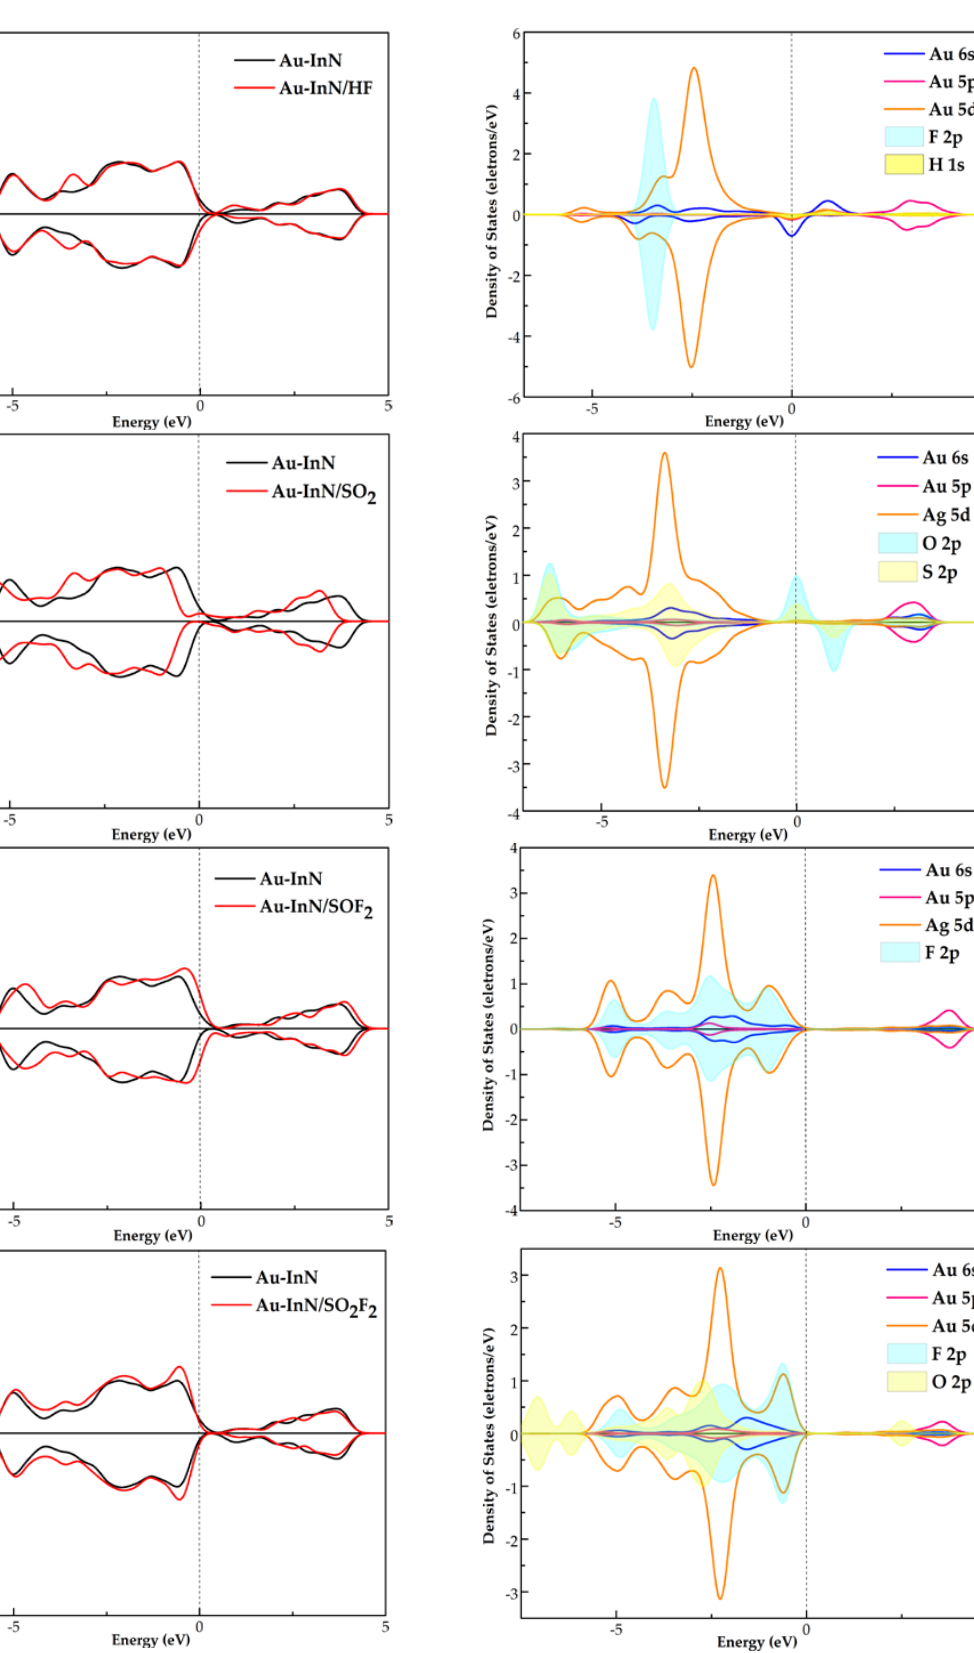
Figure 5. TDOS and PDOS of ( a ) HF, ( b ) SO 2 , ( c ) SOF 2 and ( d ) SO 2 F 2 adsorption system, the dotted line indicates the Fermi